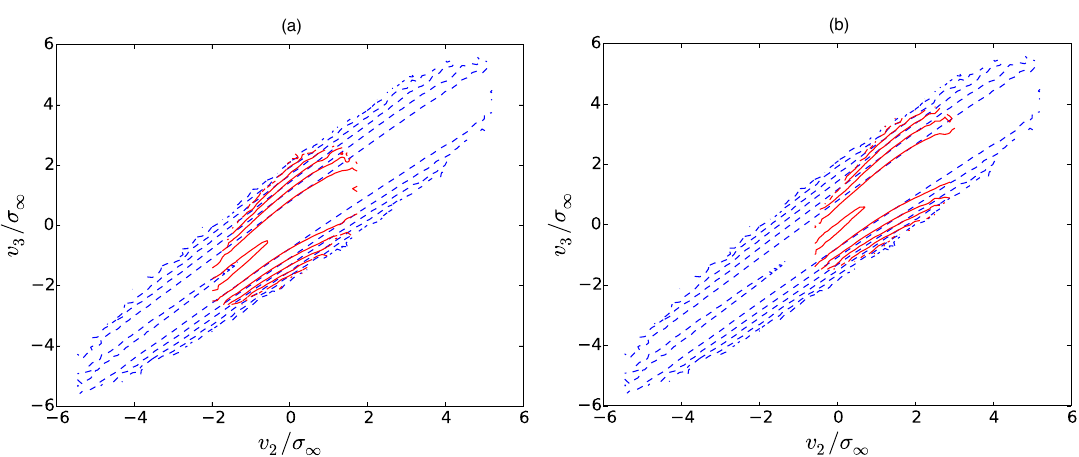
Figure 15. ( a ) examination of the Markov property (28) from DNS of the nonlocal case for ∆ r = 1 λ and v 1 = 0 via a logarithmic contour plot. ( b ) same as in ( a ), but for v 1 = σ ∞ .